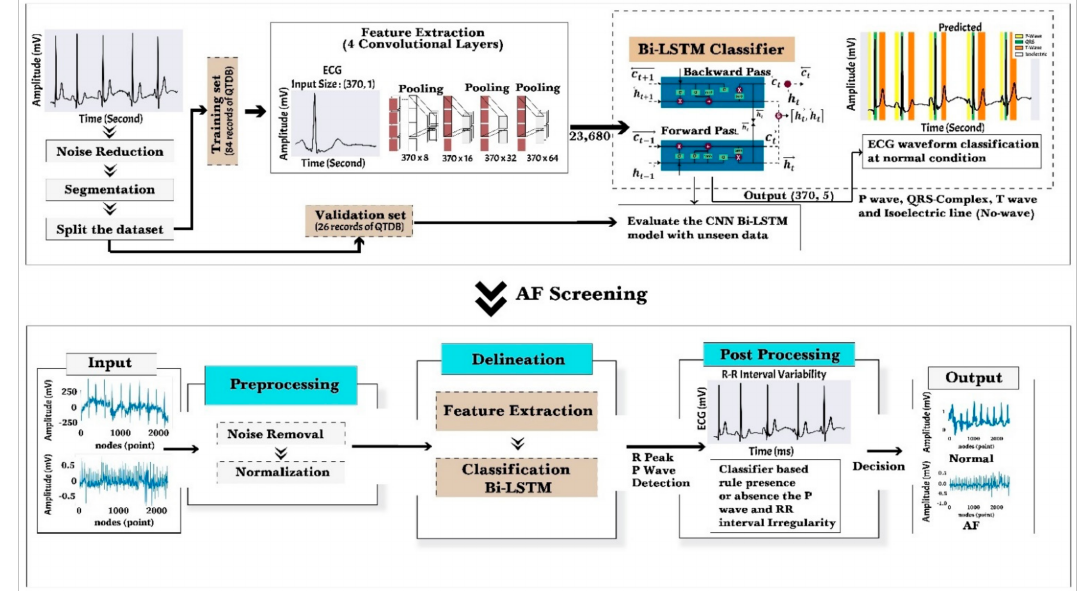
Figure 1. The proposed framework with ECG the delineation approach and AF identification. Automated ECG signal delineation is developed with convolutional layers as feature extraction and Bi-LSTM as a